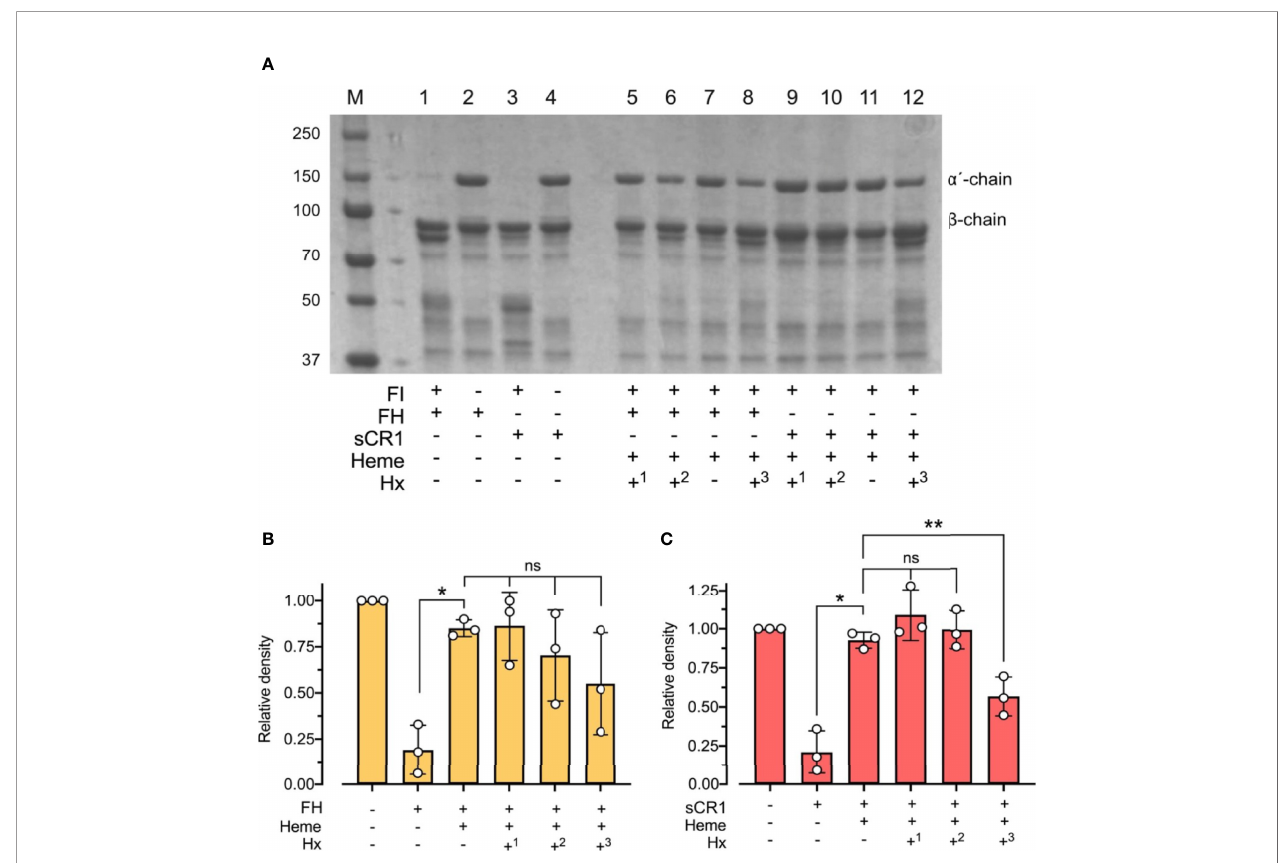
FIGURE 6 | Effect of hemopexin in heme-dependent inhibition of factor I-activity. (A) C3b (10 m g) was incubated with factor I (FI 0.1 m g), factor H (FH 0.1 m g) or soluble complement receptor 1 (sCR1 0.1 m g), heme (32 m M), and hemopexin (Hx) added at different time points for 60 minutes at 37°C. The samples were run on a 4 - 15% SDS-PAGE under reduced conditions and stained with Coomassie Brilliant Blue, shown as a representative gel from three independent experiments. Sample 1 - 4 represent controls without heme or hemopexin. Sample 5 - 12 include heme and hemopexin (40 m g/ml) added at different time points. In samples 5 and 9, FI was preincubated with heme for 15 minutes before adding C3b, co-factor, and Hx (+ 1 ). In samples 6 - 7 and 10 - 11, all components were added simultaneously, but samples 7 and 10 lack Hx (+ 2 /-). In samples 8 and 12, FI and Hx were preincubated for 15 minutes before adding C3b, heme, and FH or sCR1 (+ 3 ). (B, C) C3b-degradation was evaluated by densitometric measurement and displayed as the relative density of the C3b intact a ´-chain at 101 kDa in relation to the b -chain at 75 kDa using factor H (B) and sCR1 (C) as the co-factors. The values are shown as mean +/- standard deviation of n = 3. Ordinary or repeated- measures one-way ANOVA with Dunnett ’ s multiple-comparison and paired t-tests for the comparison of two columns were used for the statistical analysis. ns, nonsigni fi cant, *p < 0.05, **p <